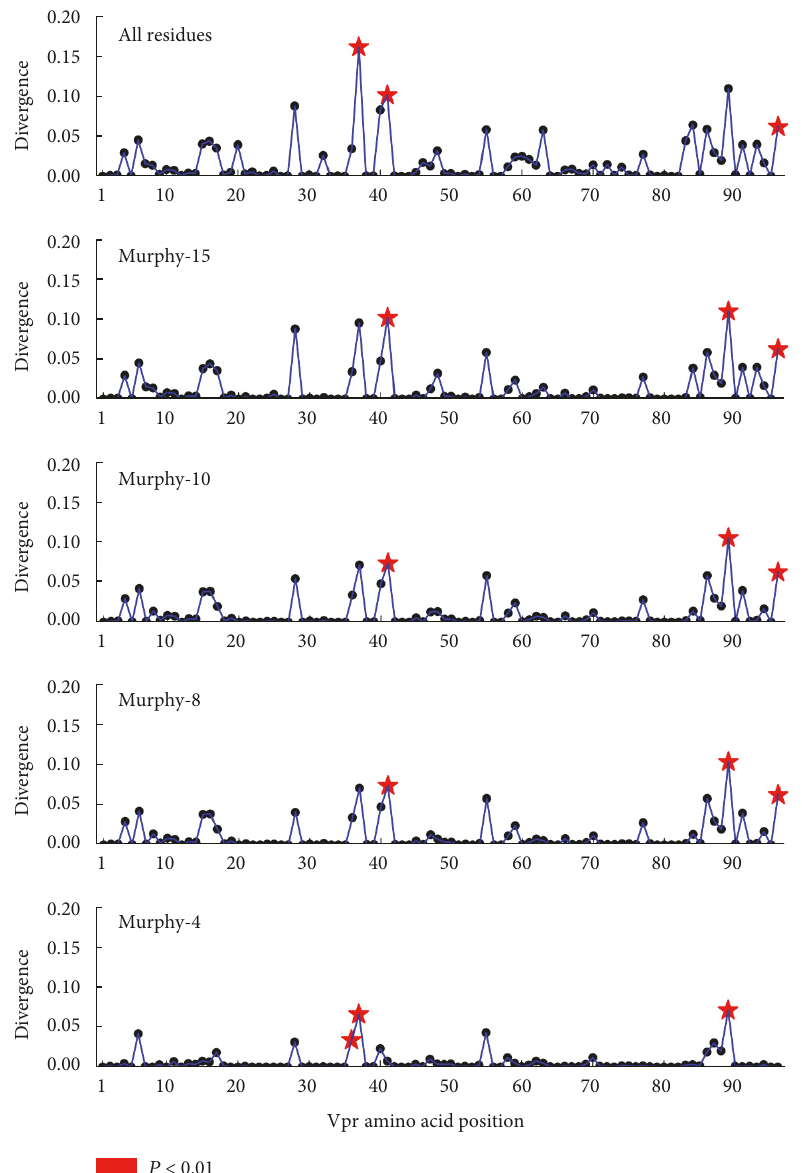
Figure 3: Jensen-Shannon divergence identi fi es positions with di ff erential amino acid pro fi les between R5 and X4 Vpr sequences. The Jensen- Shannon divergence between R5 and X4 Vpr sequences was computed for each amino acid position and plotted with a black circle. Statistically divergent positions, as determined by a one-tailed Monte Carlo permutation test (1000 iterations), are indicated by a red star ( P < 0 05 ). This methodology was repeated for each of the reduced alphabets, Murphy-15, Murphy-10, Murphy-8, and